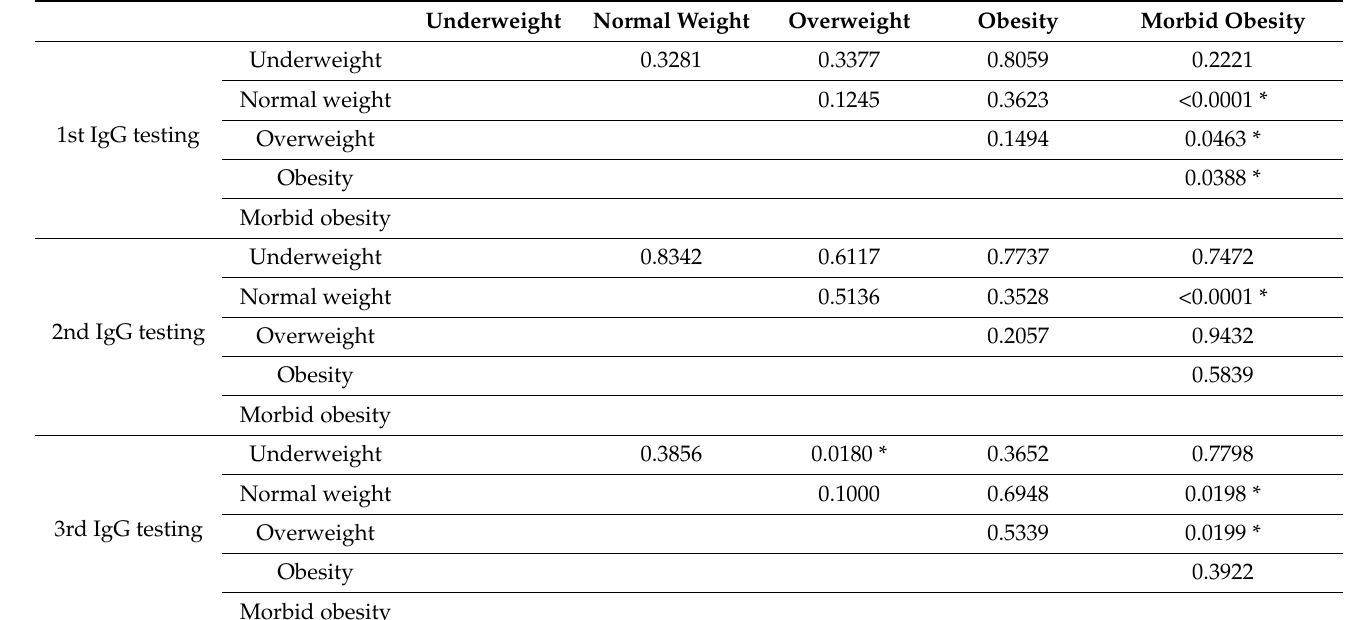
Table 6. Two-sided p -values for difference in IgG counts between body mass index (BMI) groups. * The significant difference.